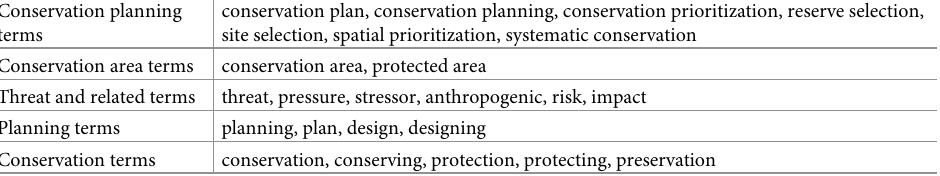
Table 2. The keywords for literature